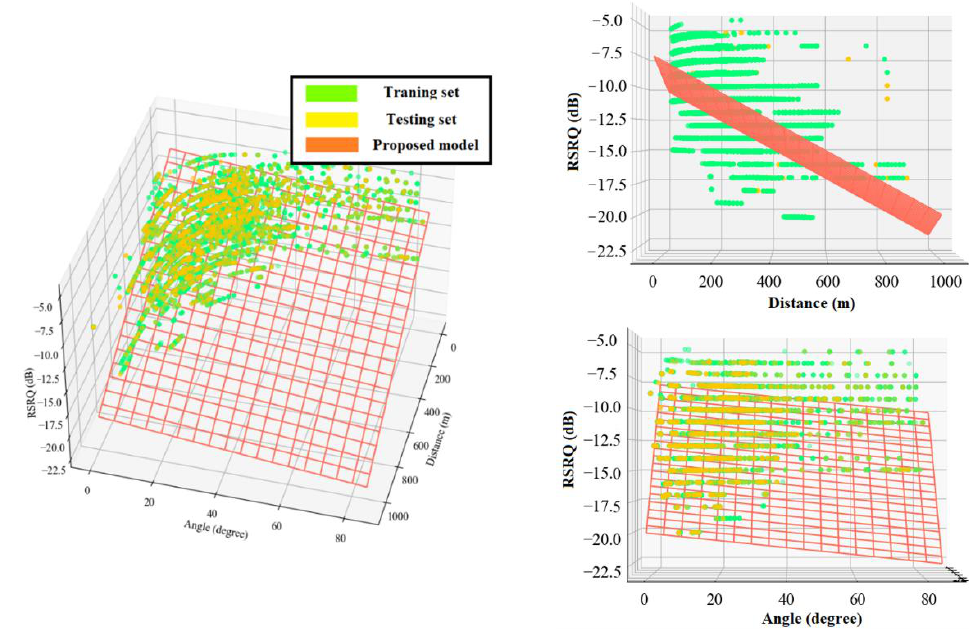
Figure 12. 3D representation of the proposed linear regression model for RSRQ. The following equations present the proposed polynomial-based RSRP and RSRQ prediction models, and Figures 13 and 14 show a 3D representation of the proposed models for the RSRP and RSRQ, respectively.